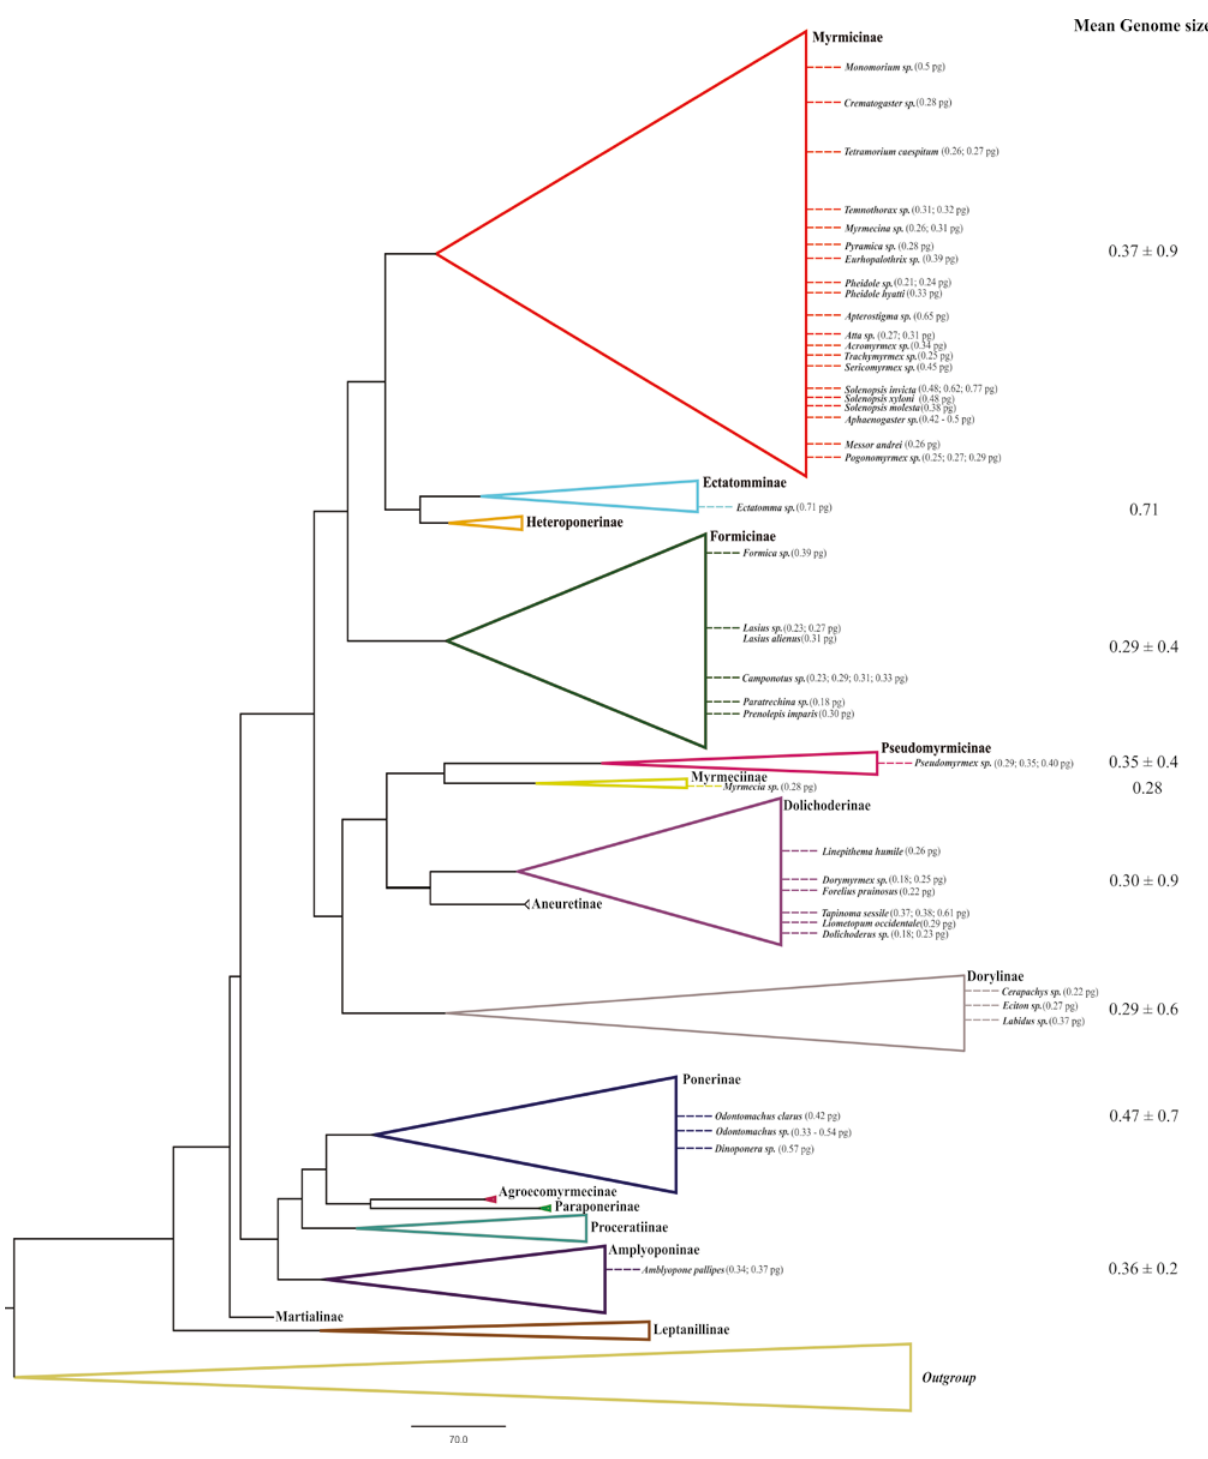
Figure 2. Phylogeny of the extant Formicidae. Phylogenetic tree redrawn from Moreau and Bell (2013). The figure highlights the subfamilies containing species with estimated genome size. Aside of each terminal on the tree the genome size is shown in picograms (pg) of DNA and also the mean genome size per Formicidae